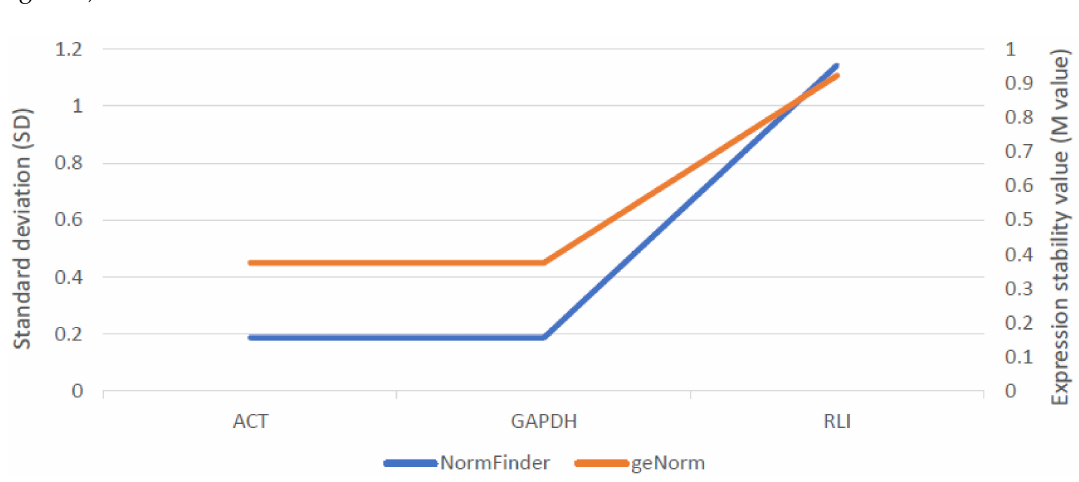
Figure 4. Stability assessment of three reference genes across all rye samples using two di ff erent algorithms: NormFinder (SD) and geNorm ( M -Value) provided in GeneEx 7.0 software (bioMCC, Freising-Weihenstephan,